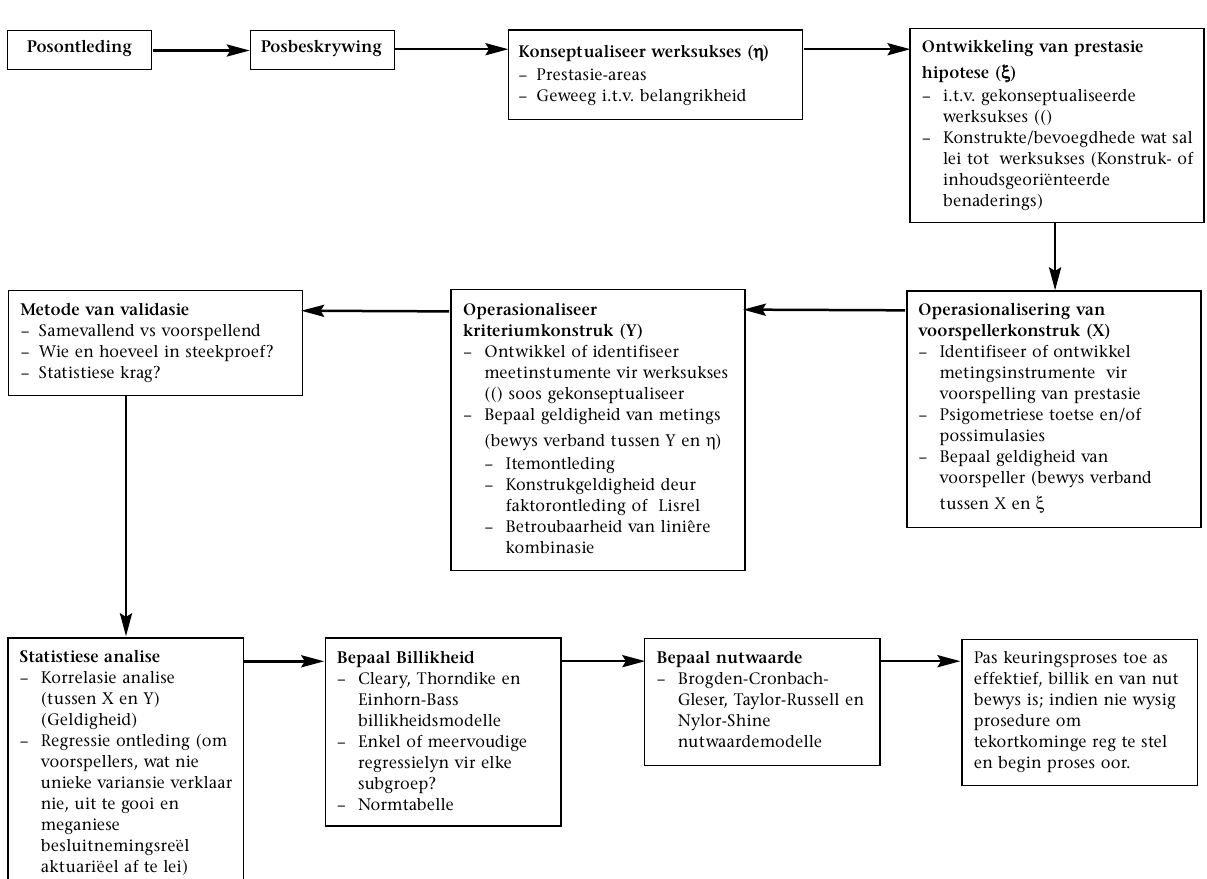
Figuur 2: Die aktuariële benadering tot die